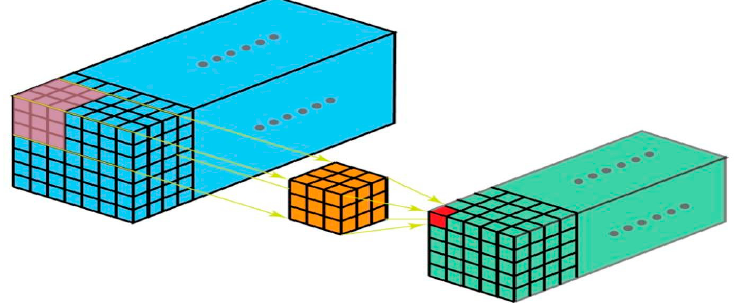
Figure 11. 3D Figure 11. 3D convolution.